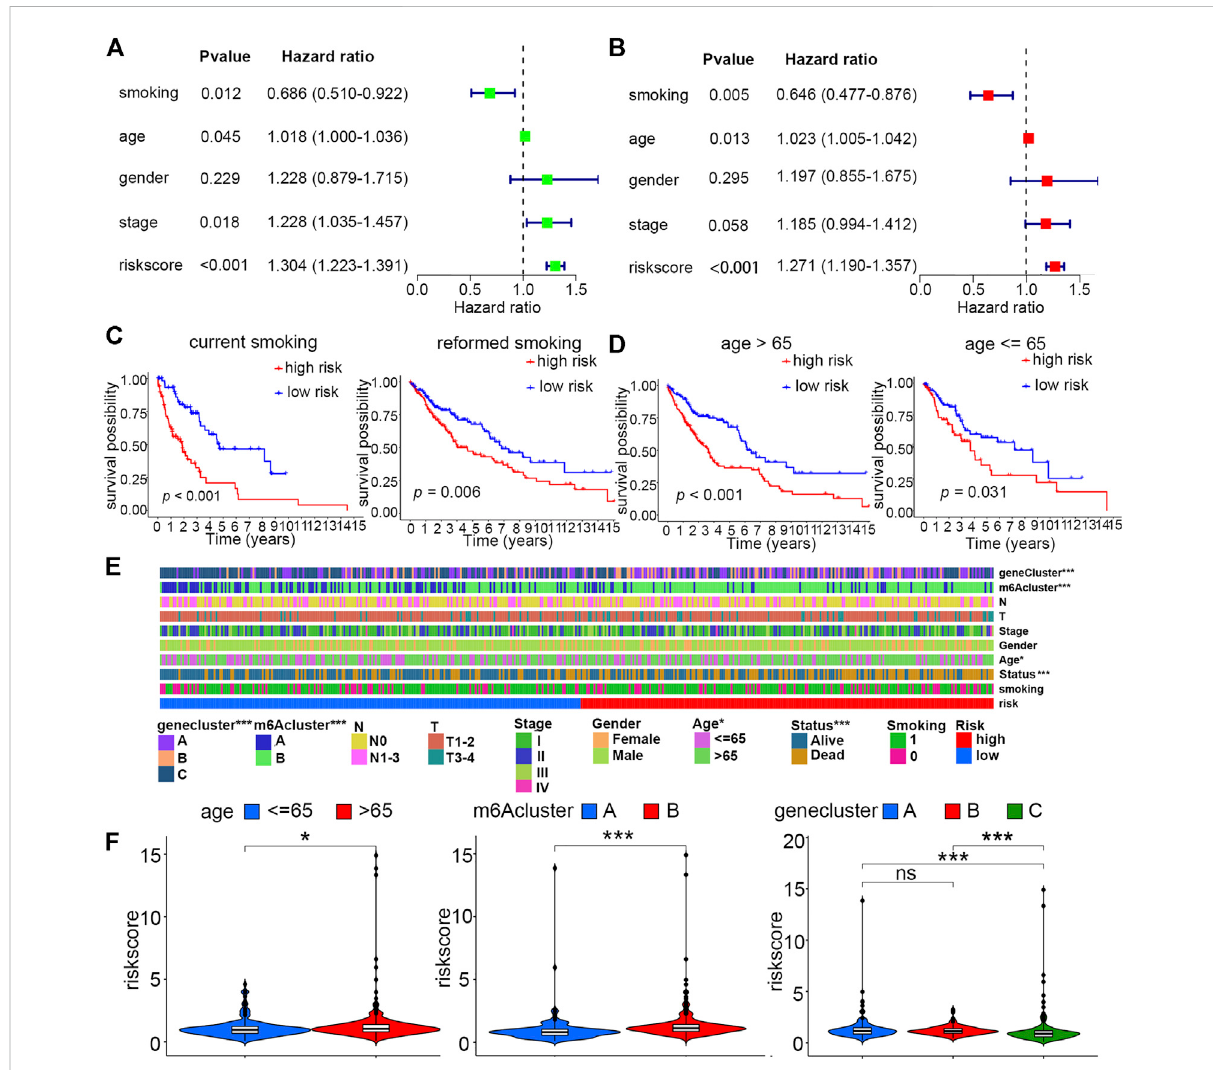
FIGURE 5 Independent prognostic and strati fi ed analyses of the risk model. (A) Univariate and (B) multivariate Cox regression analyses of risk score and other clinical features. (C) Kaplan – Meier curves of high- and low-risk groups with strati fi ed smoking history. (D) Kaplan – Meier curves of high- and low-riskgroupswithstrati fi edage. (E) Differencesinclinicalcharacteristics,m6Aclusters,andgeneclustersbetweenhigh-andlow-riskgroups(* p < 0.05; *** p < 0.001) (F) Distribution of the risk score between age, m6A cluster, and gene cluster subgroups (* p < 0.05; *** p <